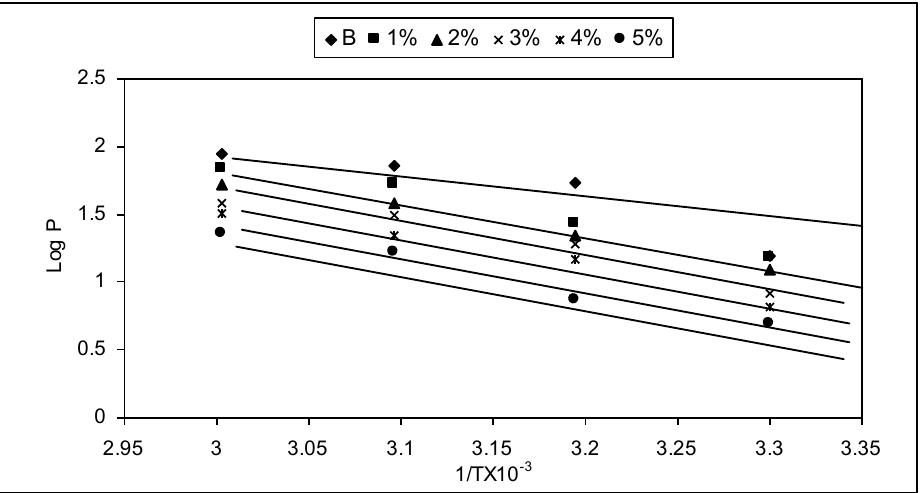
Figure 2. Arrhenius Plot for Corrosion in 2N Phosphoric acid with